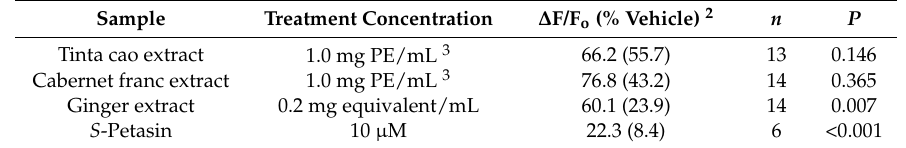
Table 1. Maximum change in GCaMP5 1 fluorescence by treatment, relative to vehicle control.